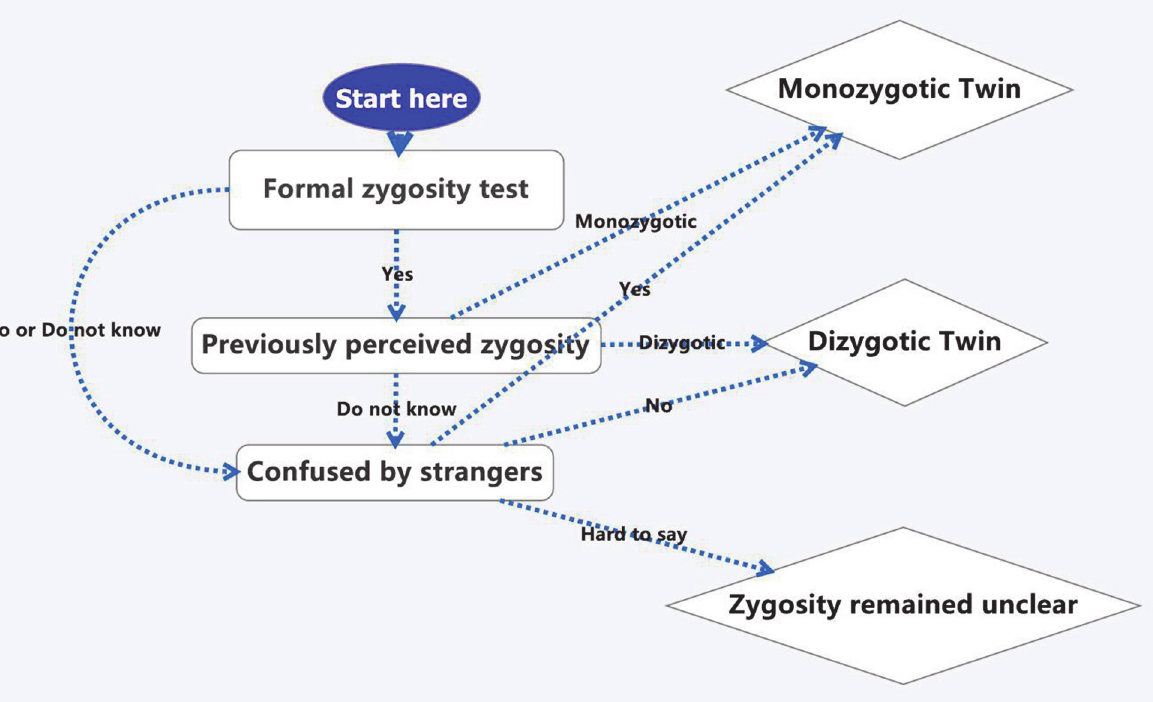
Fig 1. Complex strategy for zygosity determination based on the three question of formal zygosity test, previously perceived zygosity and confused by strangers. For example, if someone had “ Yes ” of Formal zygosity test, his zygosity would be the answer of question Previously perceived zygosity (PPZ) either “ Monozygotic ” or “ Dizygotic ” (but when he chose “ Do not know ” of question PPZ, his zygosity would be based on question Confused by strangers). On the contrary, when he chose “ No ” or “ Do not know ” in Formal zygosity test; his zygosity would be directly based on answers of Confused by strangers. In the question of Confused by strangers, “ Yes ” indicated to be identical twin, “ No ” referred to fraternal twin, “ Hard to say ” implied zygosity remained unclear.